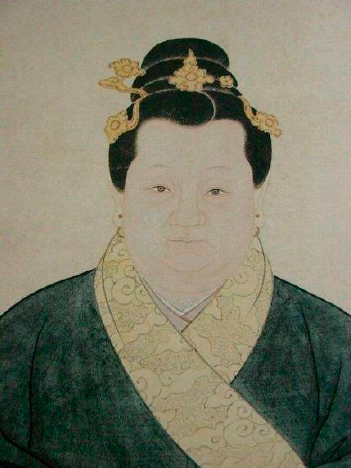
Figure 13. Left lapel dress in ancient China.